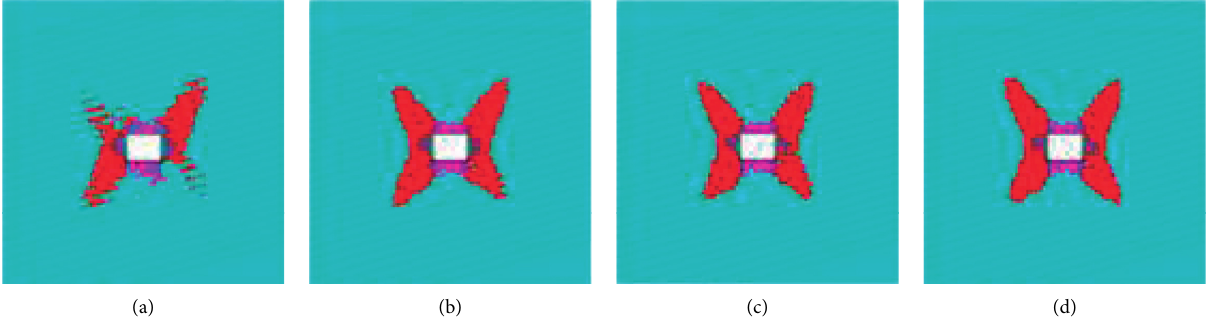
Figure 15: Morphology of plastic zone under different shear stiffness of bedding surface. (a) 0.5 e 9MPa · cm − 1 . (b) 2.5 e 9MPa · cm − 1 .